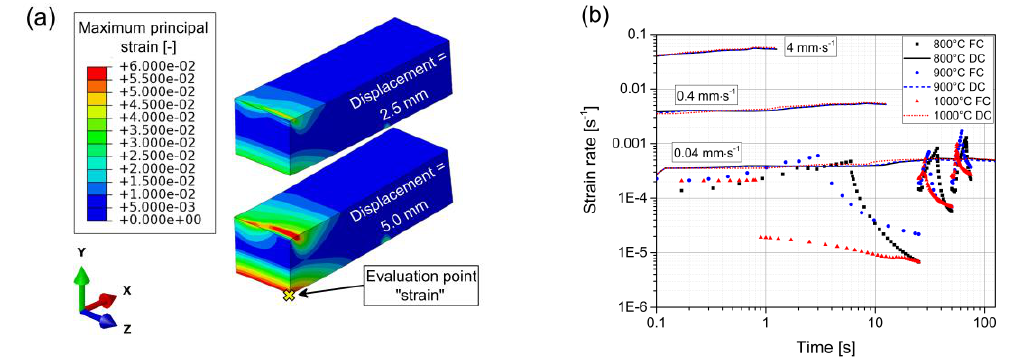
Figure 8. ( a ) Distribution of maximum principal strain in the specimen at 900 ◦ C, punch velocity 0.04 mm · s − 1 , and two representative displacement states. The evaluation point for strain rate estimations is indicated by a yellow cross. ( b ) Calculated strain rates for all simulations. The loading type abbreviations DC and FC stand for displacement- and force-controlled. The punch velocities are indicated with description boxes inside the graph for the three bundles of DC simulations.